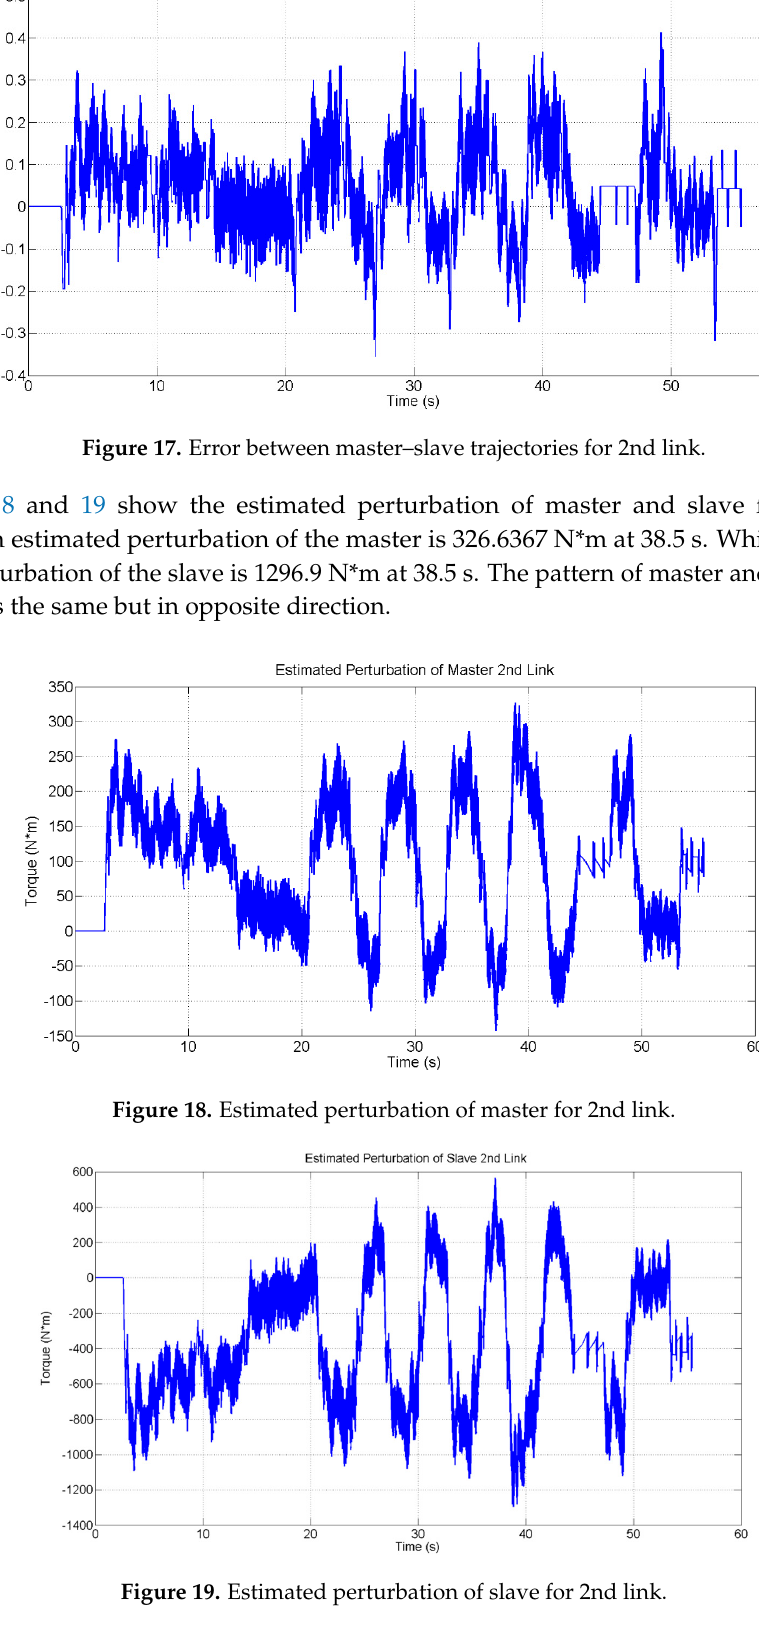
Figure 20. Normalized estimated perturbation of master and slave for 2nd link.